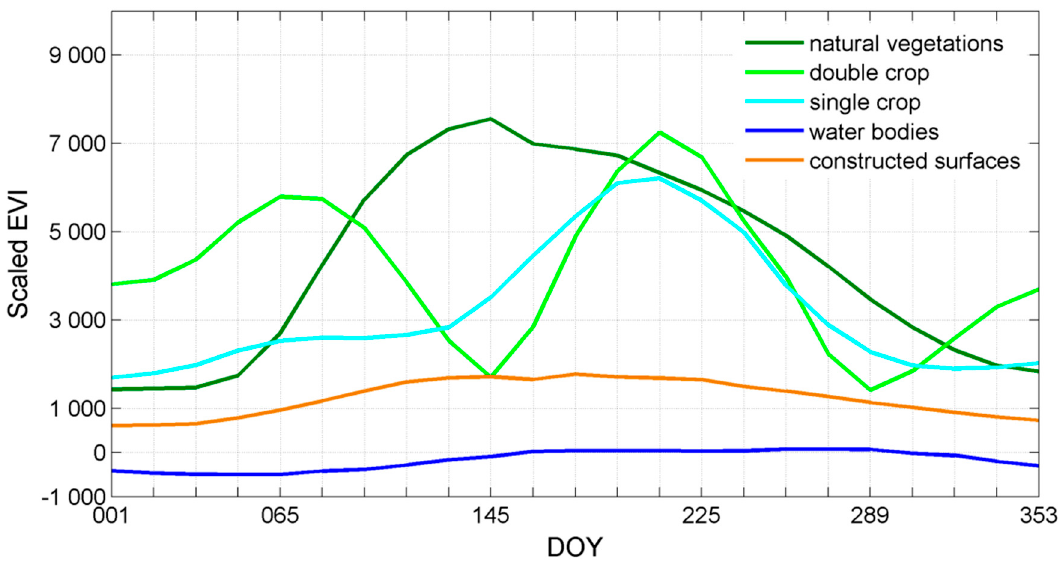
Figure 4. EVI curves for main land-cover classes in Hubei Province. DOY, the day of a year. EVI, enhanced vegetation index.